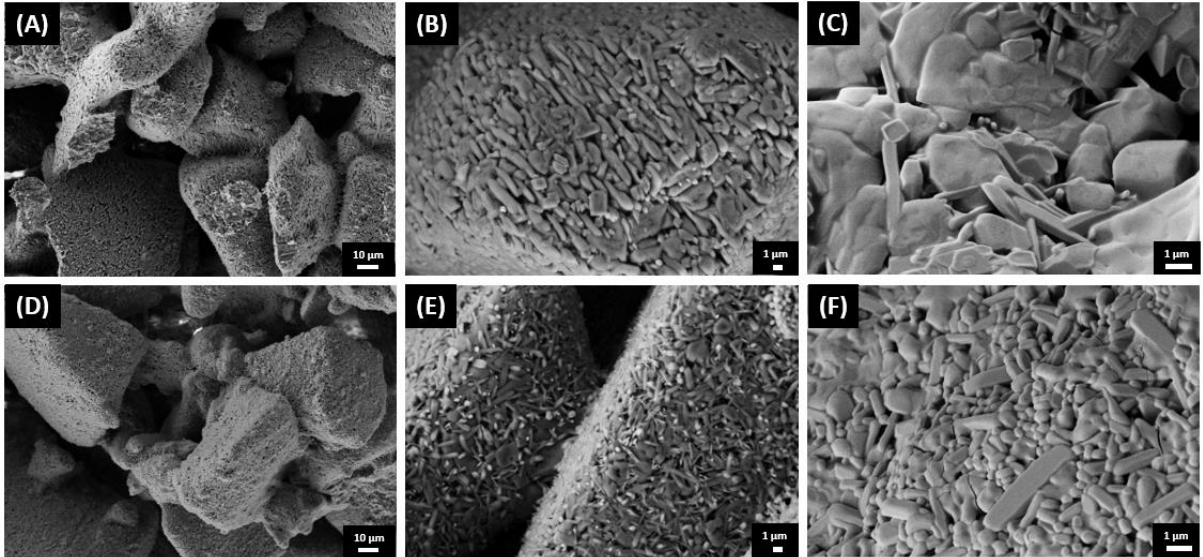
Figure 7. FE-SEM pictures of the scaffolds’ fracture surface: AP40mod ( A – C ) and 10%CB-CaP ( D – F ).